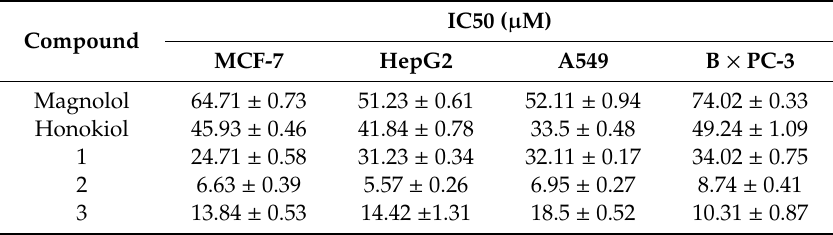
Table 1. Antiproliferative activity of compound 1, 2, and 3 against four human cancer cell lines. Compound